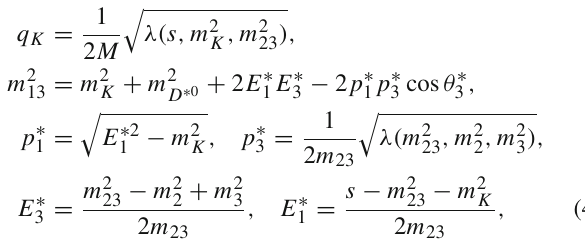
ing scalar triangle loop integral | I | 2 at the e + e − c.m. energy